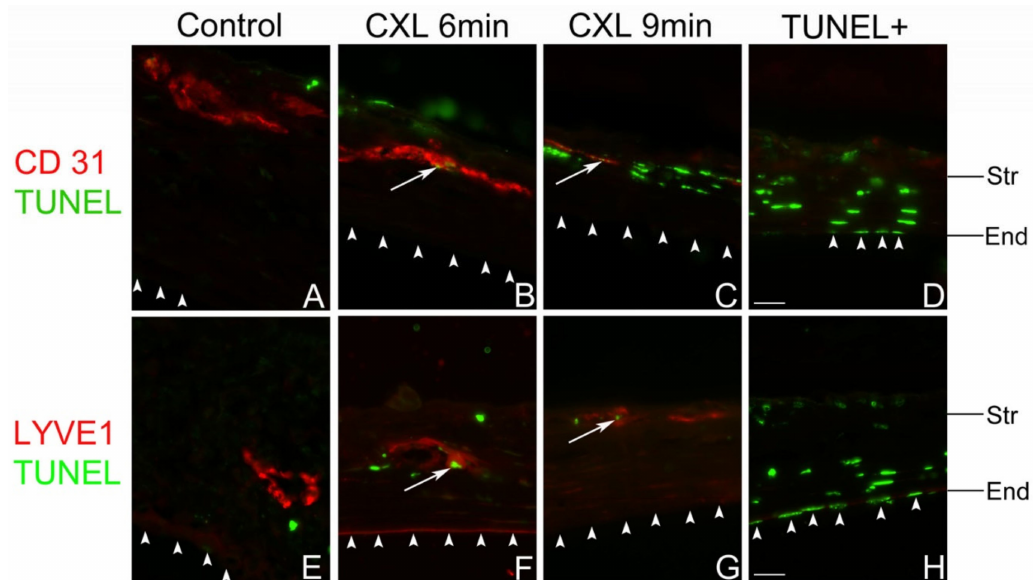
Figure 5. Apoptosis of vascular endothelial cells in corneas after UV-A-light based CXL. Representative terminal deoxynu- cleotidyl transferase dUTP nick end labeling (TUNEL) assay images of the central corneas from murine corneas 1 day after UV-A-light based CXL for 6-min ( B , F ) or 9-min ( C , G ) and non-crosslinked control corneas ( A , E ). White arrows indicate TUNEL (green) and CD31+ ( A – D ) or lymphatic vessel endothelial hyaluronan receptor 1 (LYVE1) + ( E – H ) (red) vascular endothelial cells in each panel. Corneal nonvascular endothelial cells are TUNEL negative in all groups; ( D , H ) positive control of TUNEL staining (Str: stroma; End: nonvascular endothelium. Colocalization: white arrow. Corneal nonvascular endothelium: white arrowhead. Magnification: × 600. Scale bar: 20 µ m). Corneal epithelium is missing in the treatment groups due to corneal abrasion. From Hou et al. 2018 [24].